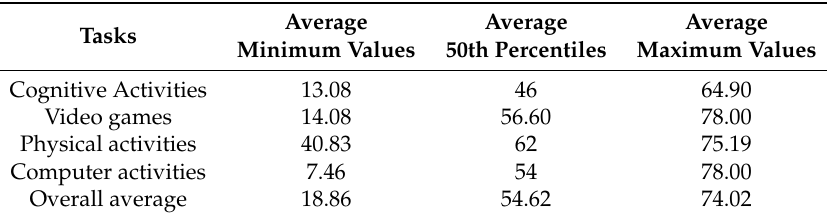
Table 2. Minimum, 50th percentiles and Maximum averages values grouped by task.